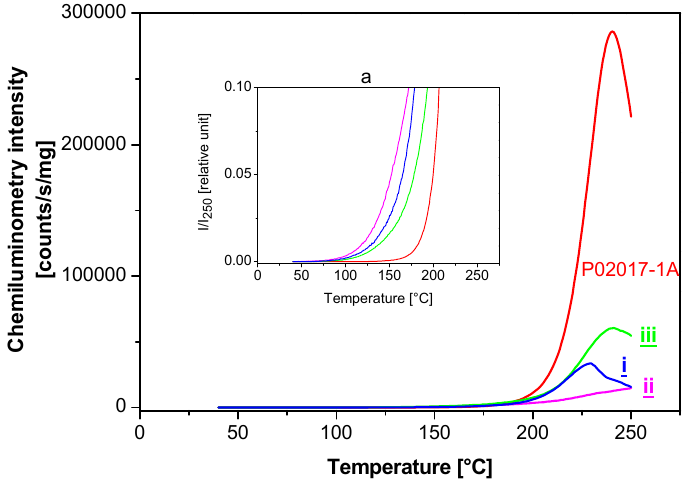
Figure 7. Non-isothermal chemiluminometry of four biopolymeric samples. The samples were measured in oxygen. Native HA sample P0207-1A, recovered polymers prepared by treating native HA sample with WBOS without addition of bucillamine ( i ) and with addition of bucillamine in the system before the reaction onset ( ii ) and after 1 h ( iii ). The inserted plot ( a ) is a cross-section of the original runs in relative units where intensity of chemiluminescence is plotted to 10% of its maximum value.